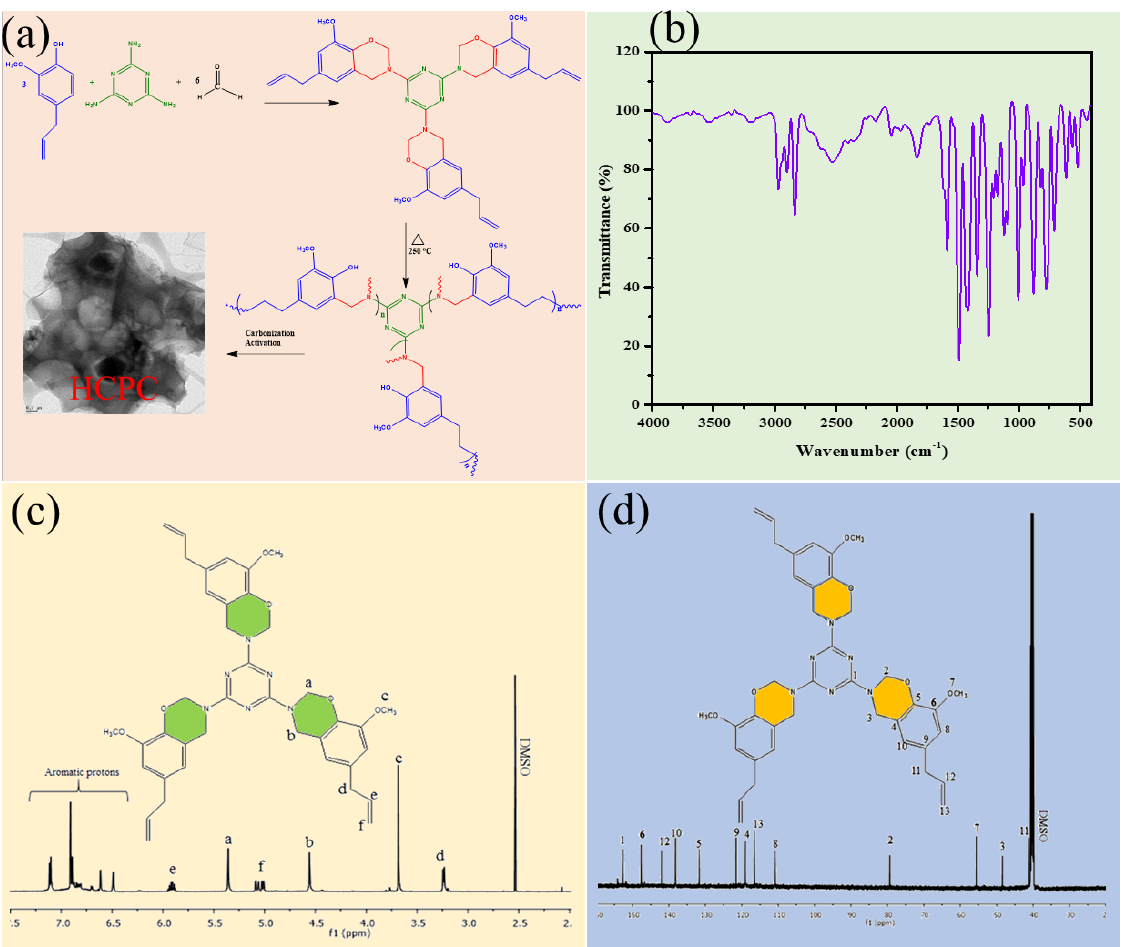
Figure 1. ( a ) Synthesis of (EM-Bzo & HCPC) and FT-IR, 1 H & 13 C-NMR spectra of benzoxazine monomer (EM-BZo) ( b – d ).